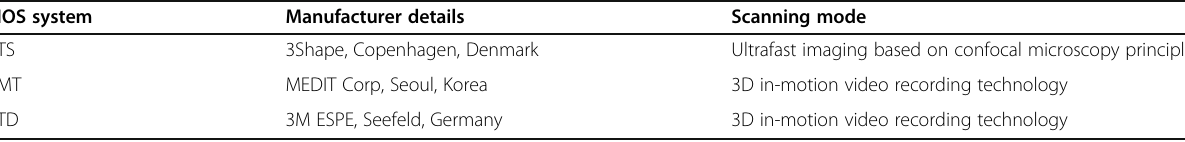
Table 1 Details of the used IOS Systems for Digital Impressions IOS system Manufacturer